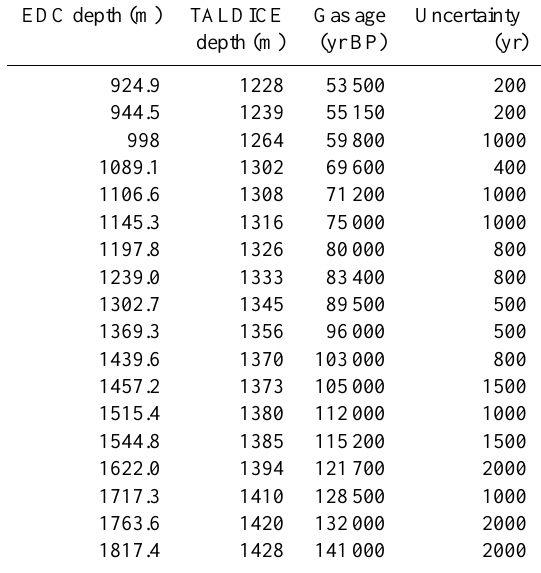
Table 2. Tie points defined by CH 4 record synchronization between TALDICE and EDC ice cores on the EDC3 age scale.